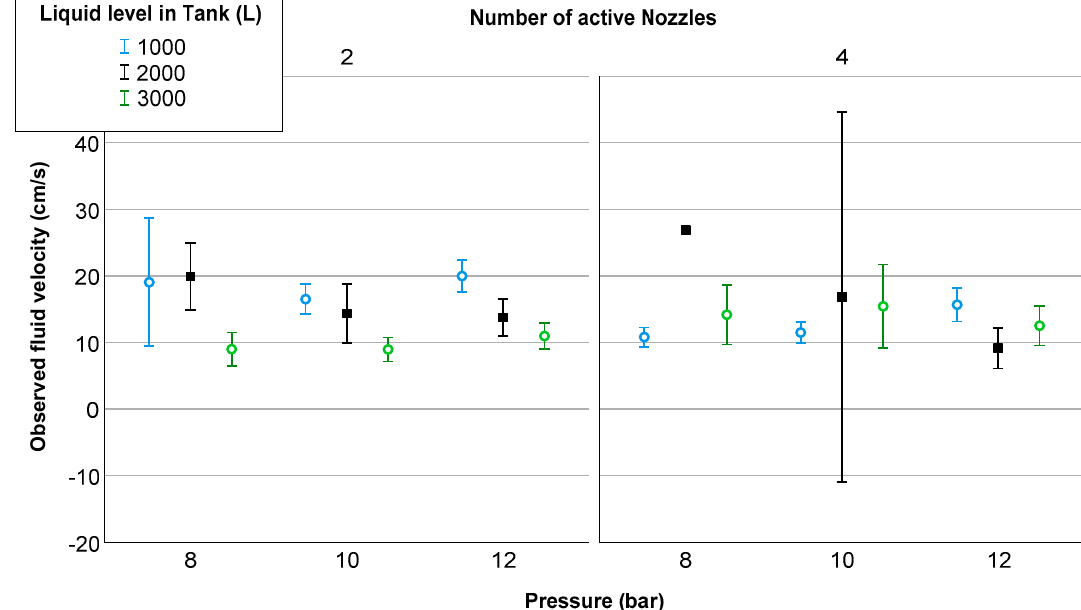
Figure A1. A 95% confidence interval of observed fluid velocity, whose residues exceed twice the prediction interval of the adjustment made by the GLMM model (Figure 5), according to the liquid level in tank, circuit pressure, and number of active nozzles.